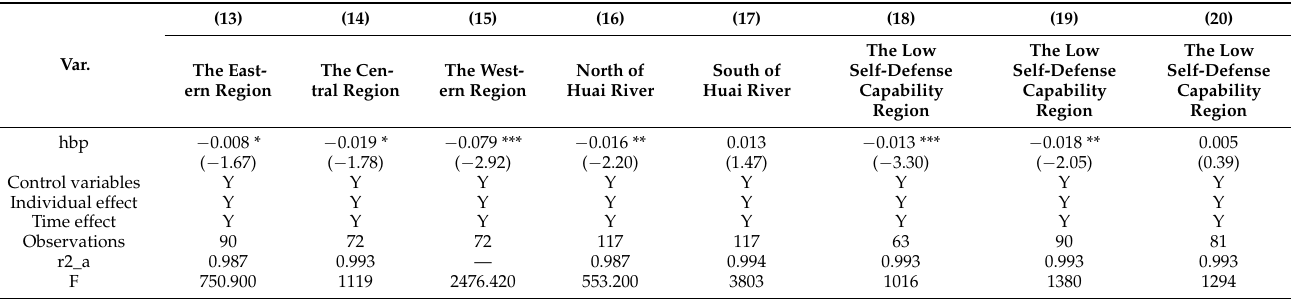
Table 4. Estimated results of heterogeneous